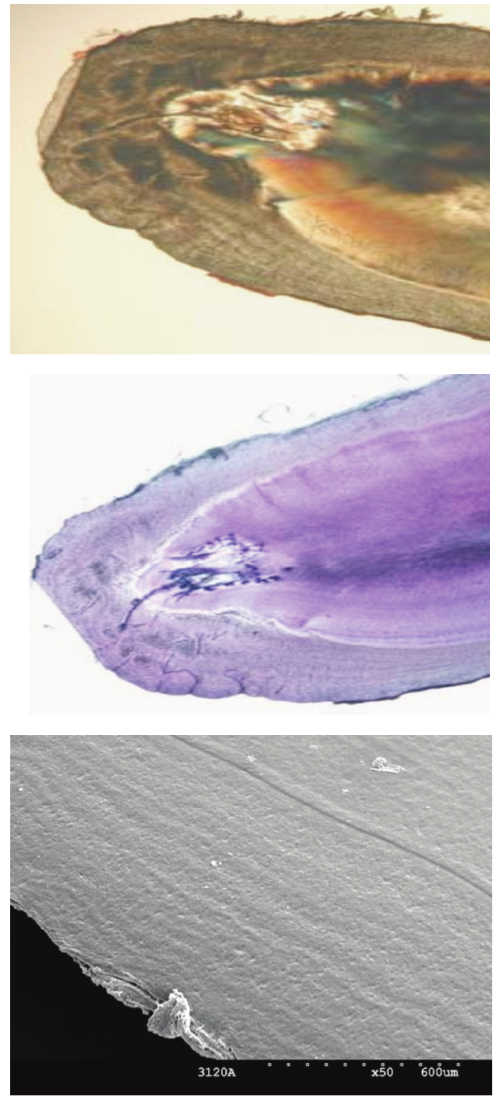
Fig. 5. Buccal-lingual sections of canine tooth from a harbour seal known to be 11 years old when it died viewed a) with trans- mitted polarized light b) decalcified and stained, and c) under the SEM. The pulp is occluded in this